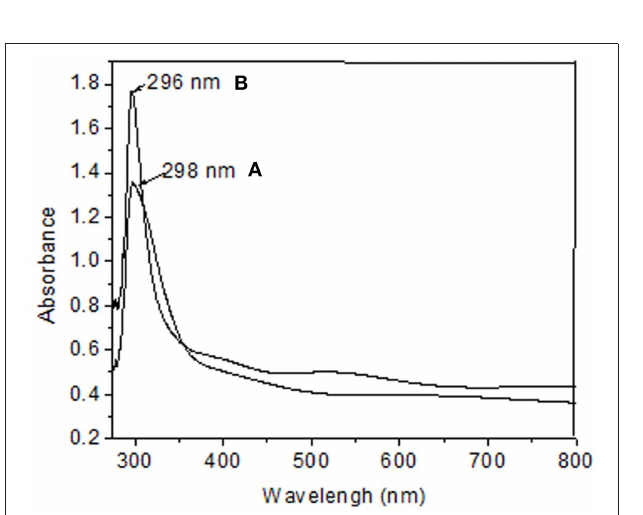
FIGURE 7 | Absorption spectra of ZnS thin films deposited from (A) Zn(cinnamtscz) 2 and (B) Zn(4-Clbenztscz) 2 at 450 ◦ C.